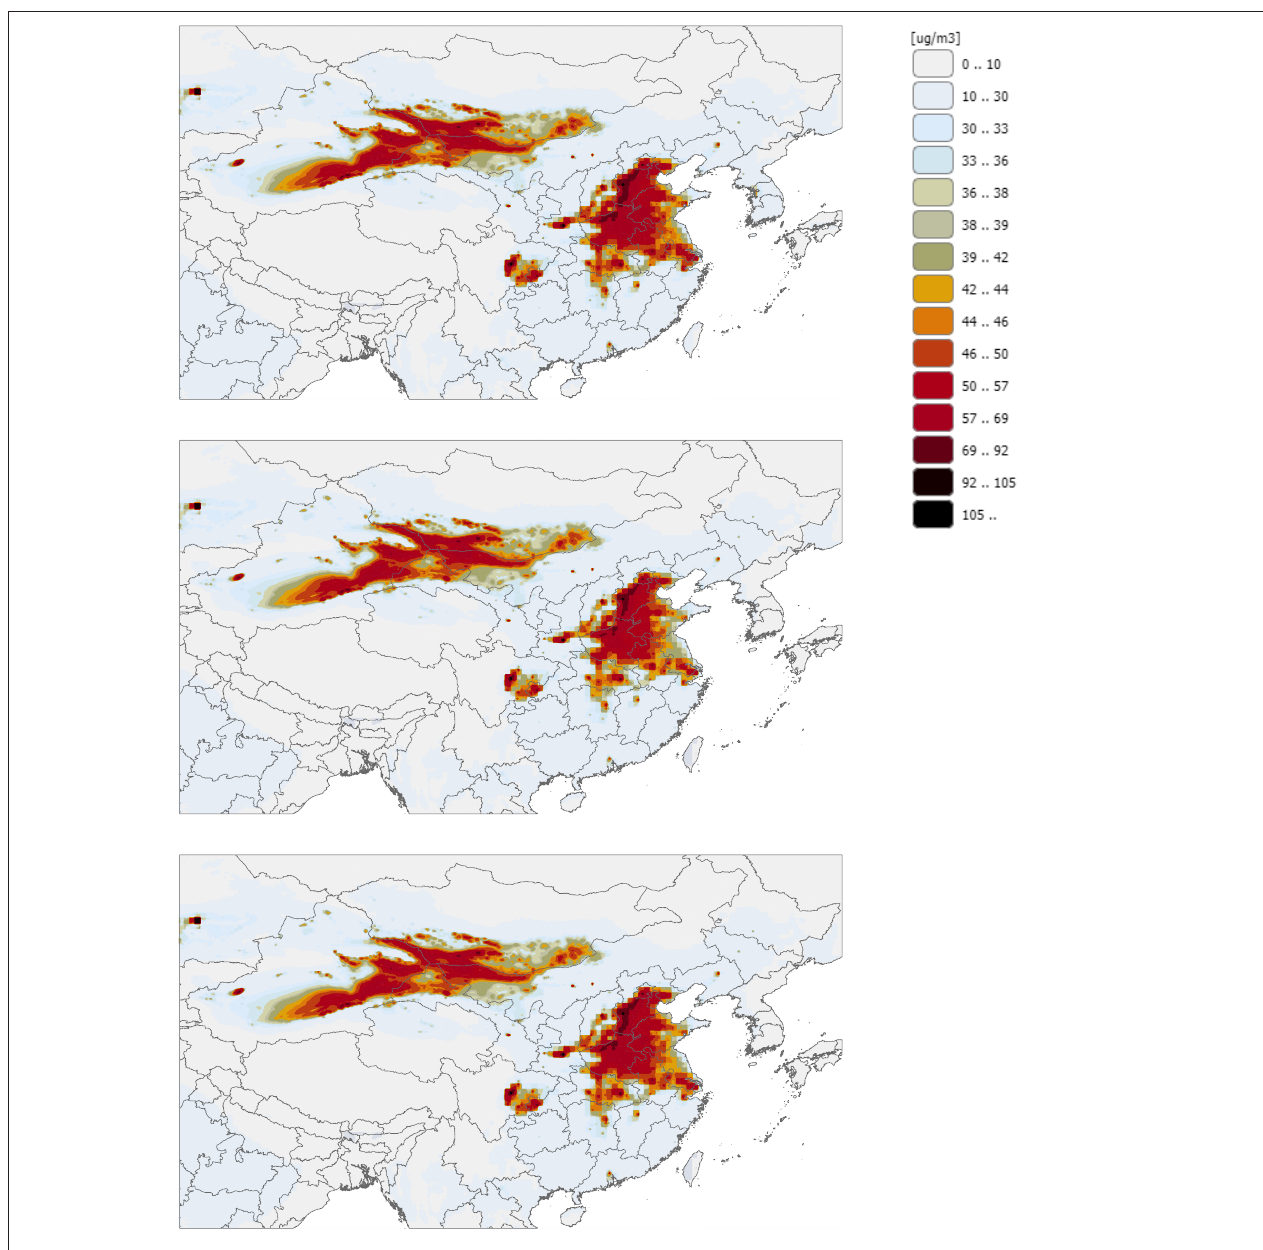
FIGURE 1 | Concentrations of PM 2.5 projected in China in 2030 under three energy scenarios . The top map shows the business-as-usual scenario (0% reduction of coal-fired power plant emissions). The middle map shows Scenario 1 wherein coal-fired power plant emissions are eliminated and renewable energy replaces coal. The bottom map shows Scenario 3 wherein coal-fired power plant emissions are reduced by 32% and renewable energy replaces